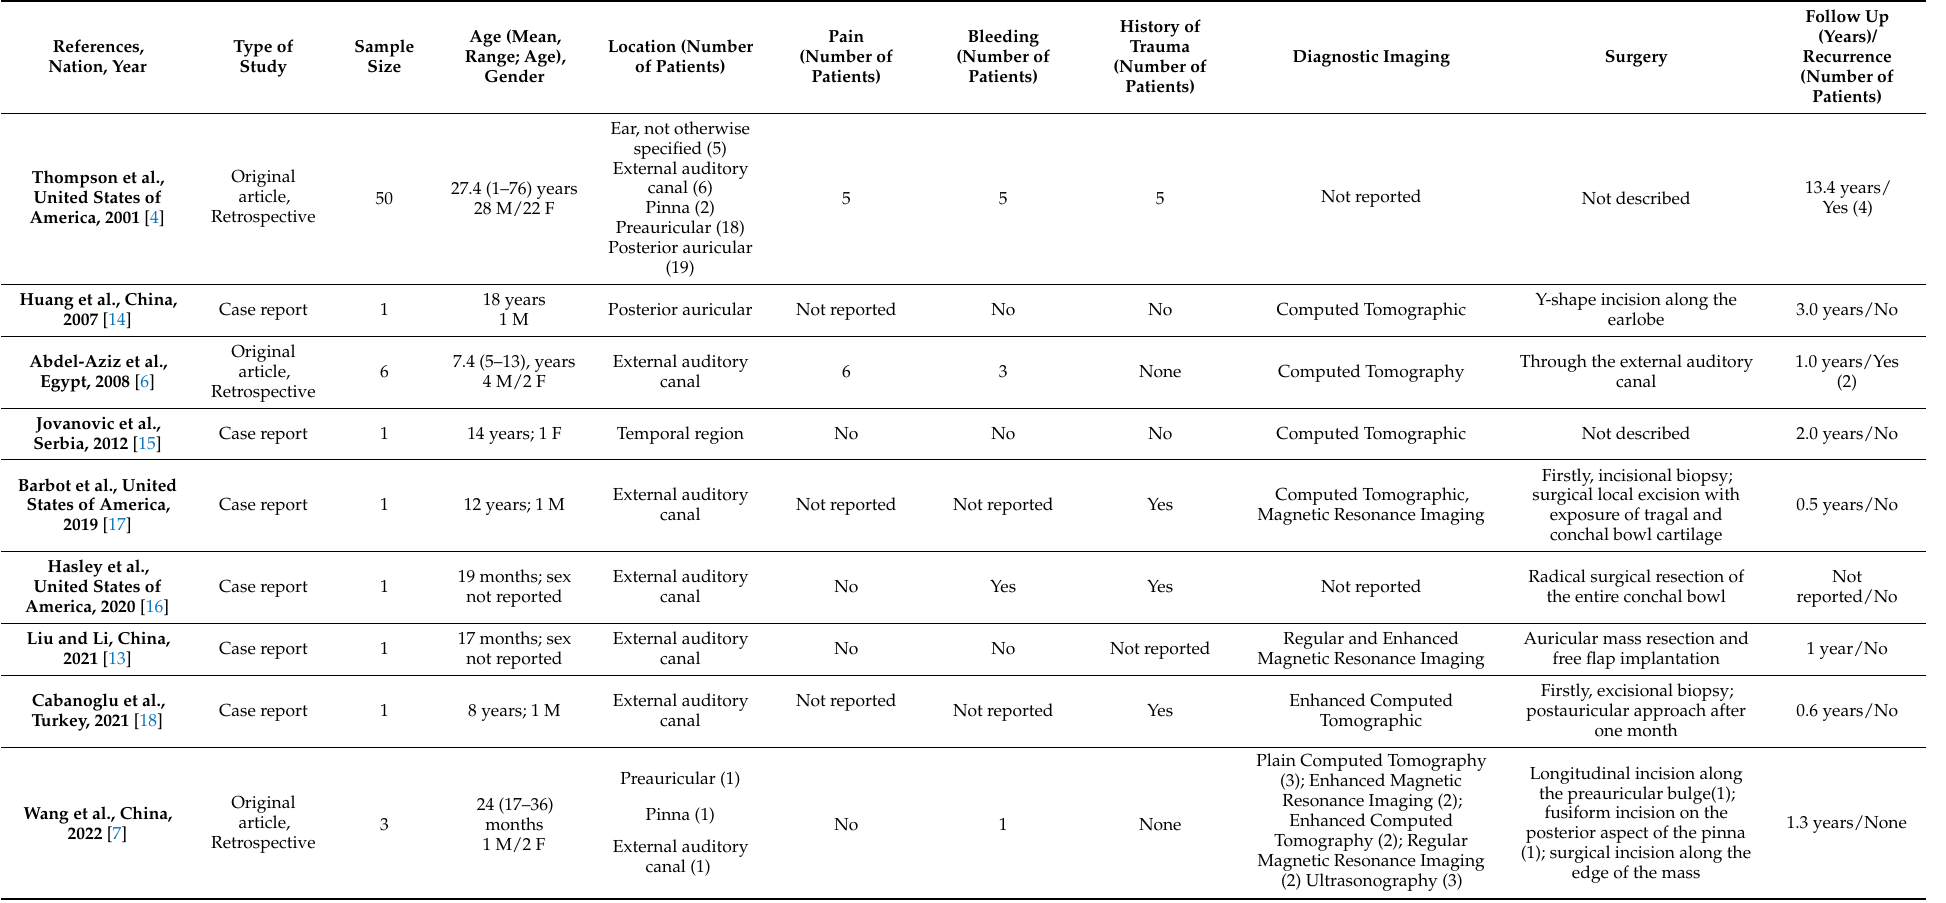
Table 1. Characteristics of nine studies included in the literature